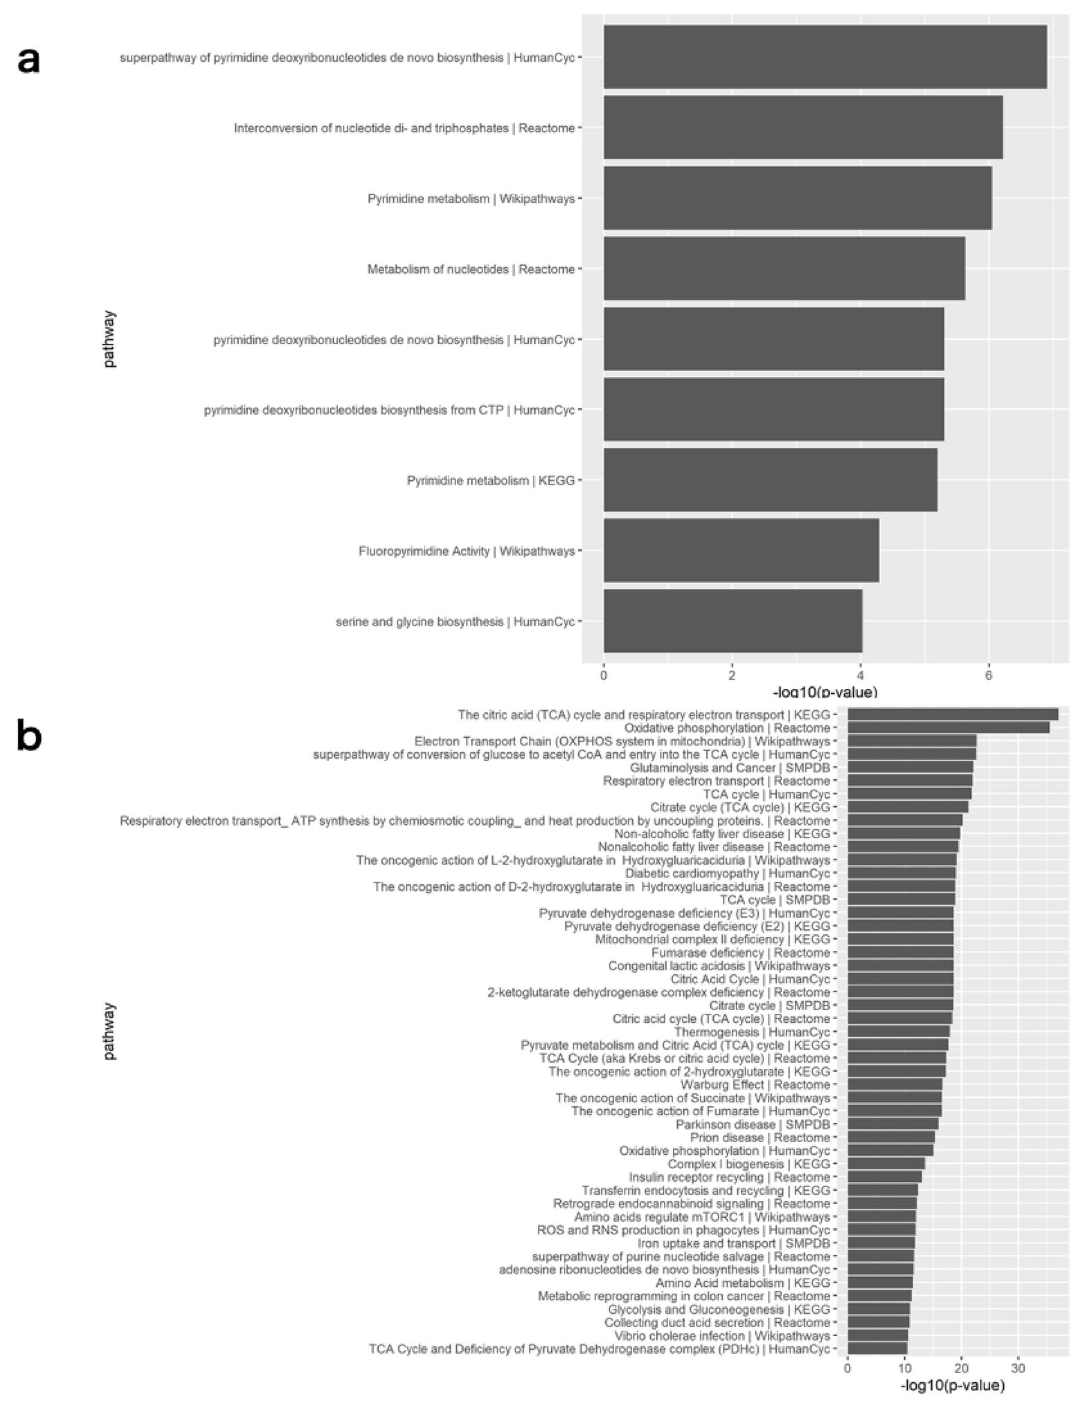
Figure 2. Enriched molecular pathways with pathway overrepresentation analysis in 32 enzymes with 1.5-fold higher expressed and p-value < 0.05 and 67 enzymes with 0.67 (= 1/1.5)-fold lower expressed and p-value < 0.05 in the Positive compared to the Negative through the use of IMPaLA. The protein data from a gene by sample matrix is transformed to a gene-set by sample matrix with gene set variation analysis (R package gsva version 1.38.0). ( a ) Upregulated pathway analysis. ( b ) Downregulated pathway